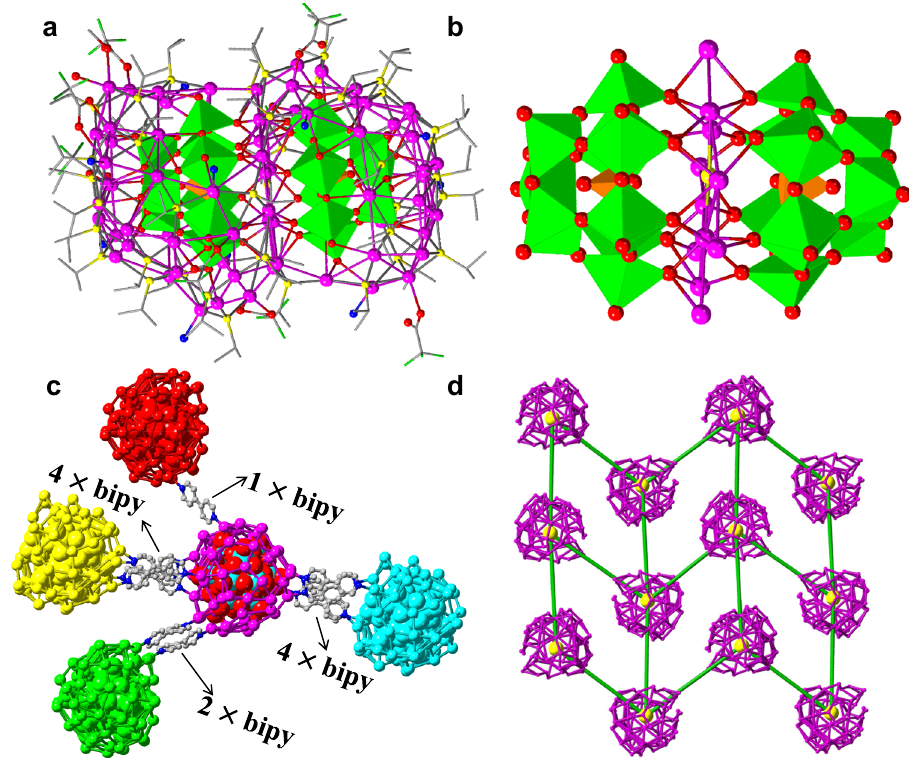
Fig. 3 Crystal structure of SD/Ag72a. a [(PW 9 O 34 ) 2 @Ag 72 ] cluster with the ligands and ( b ) highlighting the sandwiched S 2 − -centered silver plane by two PW 9 O 34 9 − . Color labels: same as Fig. 1. Only N atoms of coordinated bipy are shown for clarity. c The connections between [(PW 9 O 34 ) 2 @Ag 72 ] clusters. PW 9 O 34 9 − is shown in space- fi lling mode. d The simpli fi ed 2D 4 4 - sql network with [(PW 9 O 34 ) 2 @Ag 72 ] as node (yellow balls) and bipy as linker (green